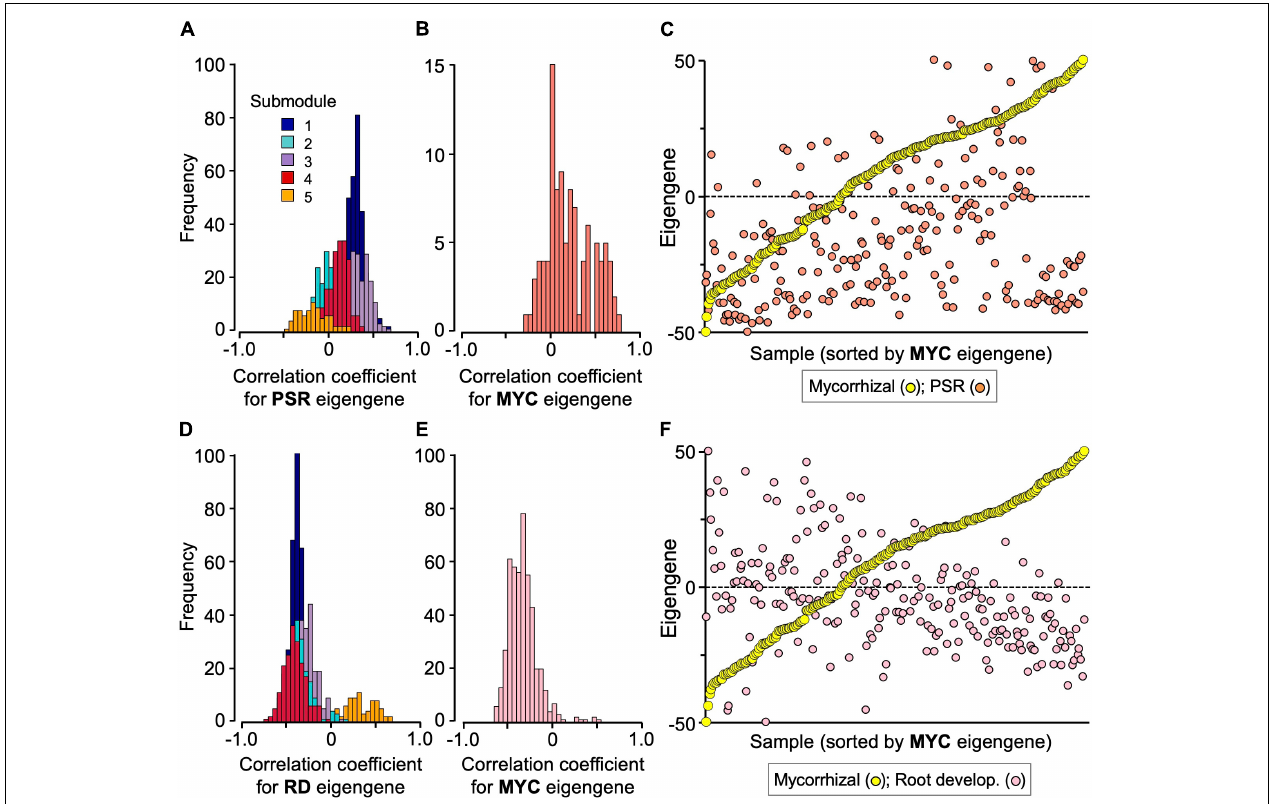
FIGURE 4 | Interplay of the mycorrhizal (MYC) module with the PSR and root development (RD) modules. (A) Frequency distributions of correlation coefficients of the mycorrhizal submodule genes with PSR module eigengenes, and (B) those of the PSR module genes with mycorrhizal module eigengenes. (C) Scatter plot of the eigengenes of the mycorrhizal and PSR modules of the 251 samples, in which the samples were sorted by the order of mycorrhizal module eigengenes. (D) Frequency distributions of correlation coefficients of the mycorrhizal submodule genes with the root development module eigengenes, and (E) those of the root development module genes with the mycorrhizal module eigengenes. (F) Scatter plot of the eigengenes of the mycorrhizal and root development modules of the 251 samples, in which the samples were sorted by the order of mycorrhizal module eigengenes. The data were extracted from Supplementary Tables 7, 8 , and all the eigengenes were standardized between –50 (minimum value) and +50 (maximum value) for plotting. The submodule numbers of the mycorrhizal module genes are indicated with the following colors: 1, dark blue; 2, turquoise; 3, purple; 4, red; 5,